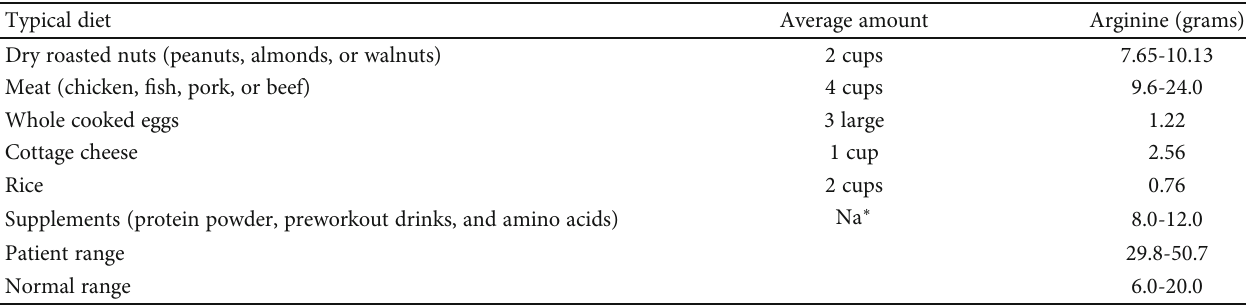
Table 2: A diet recall highlighting food and supplements containing high levels of L-arginine. The daily arginine intake ranged from 29.8 – 50.7 grams, averaging 40.2 grams/day. Arginine amount derived from the USDA National Nutrient Database (http://www.ars.usda.gov/